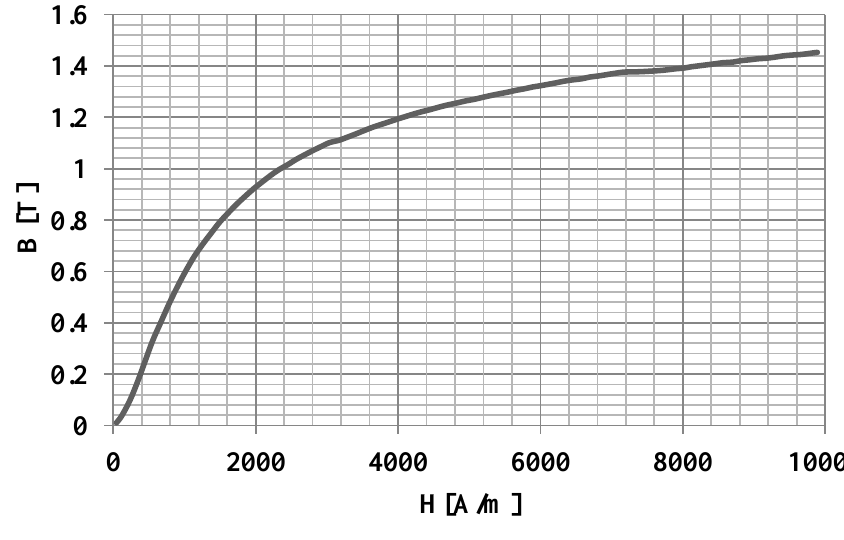
Figure 10. Characteristic of magnetization of Somaloy